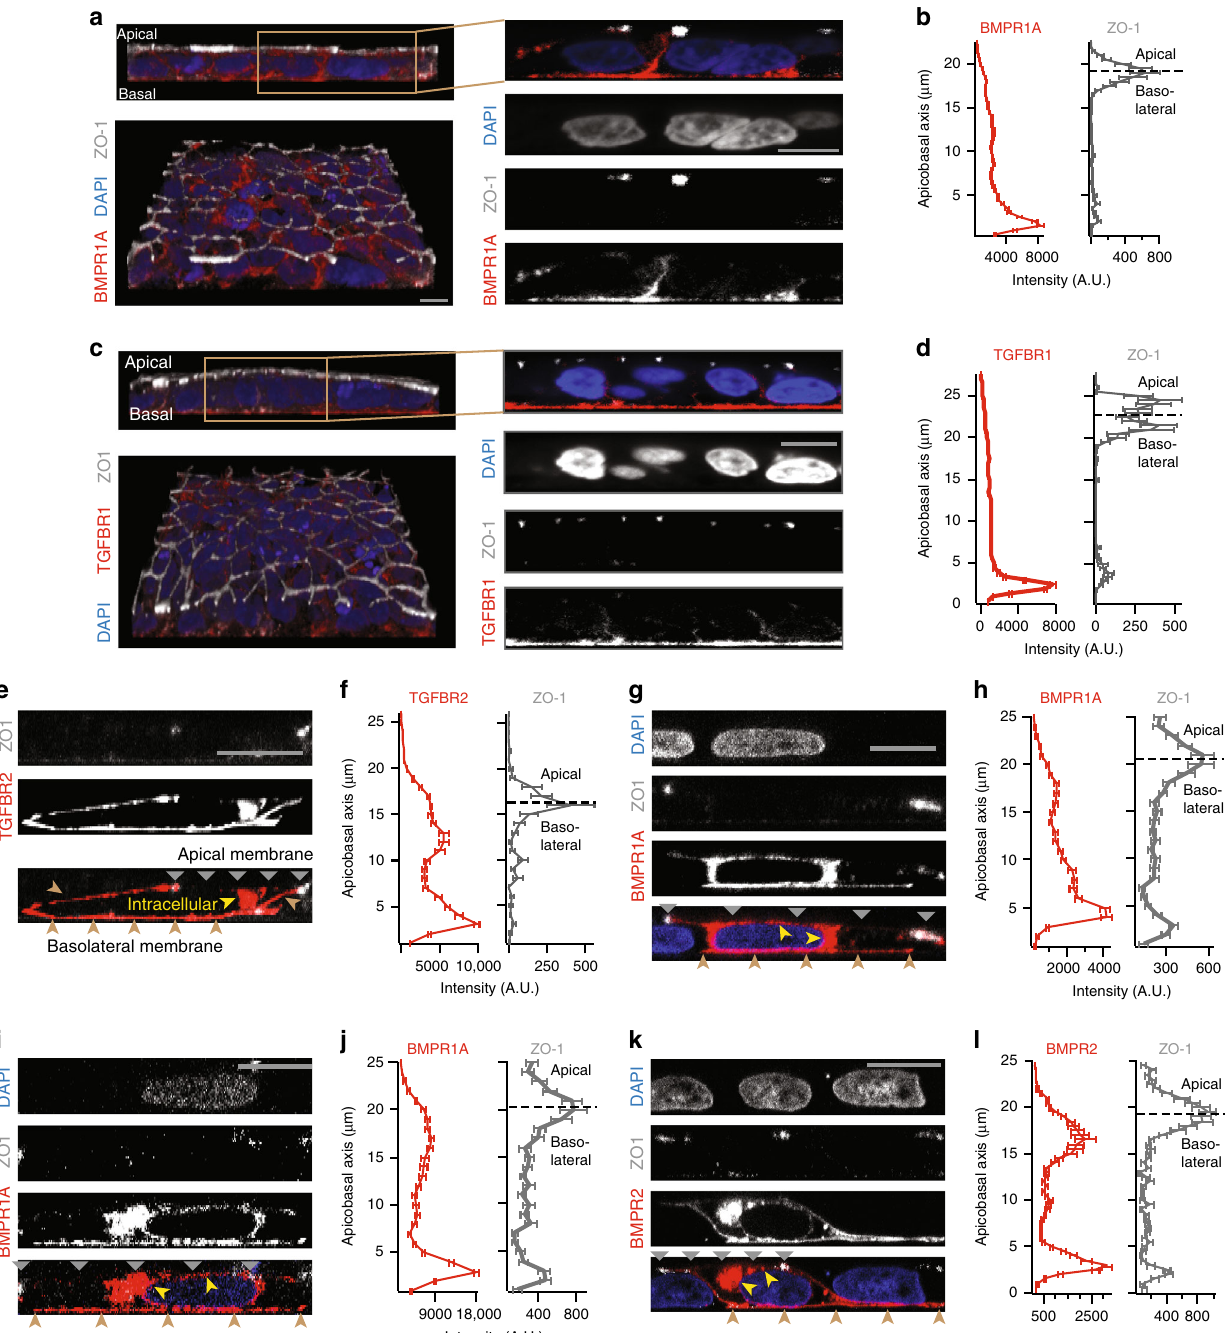
Fig. 2 BMP and TGF- β receptors localize at basolateral membrane of hESCs in vitro. a Left column: 3D confocal images of hESC colony stained for BMPR1A (red), tight junction marker ZO-1 (white), and DNA (blue), in lateral (top) and tilted view (bottom). Right column: Zoomed-in lateral images. Scale bar 10 µ m. b Plots of BMPR1A (left) and ZO-1 (right) staining intensity along apicobasal axis show BMPR1A localized beneath tight junctions ( n = 38 cells from two experiments). c Left column: 3D confocal image of hESC colony stained for DNA (blue), TGFBR1 (red), and ZO-1 (white) in lateral (top) and tilted view (bottom). Right column: Zoomed-in lateral section. d Plots of TGFBR1 (left) and ZO-1 levels (right) against apicobasal axis show that TGFBR1 is localized below tight junctions ( n = 51 cells from two experiments). e Confocal image of a hESC expressing TGFBR2-Clover (red), stained for ZO-1 (white). f TGFBR2-Clover (left) and ZO-1 levels (right) against apicobasal axis ( n = 4 cells from two experiments). g , h Same as e , f but for BMPR1A-Clover ( n = 2 cells from two experiments). i , j Same as e , f but for BMPR1A-HA ( n = 3 cells from two experiments). k , l Same as e , f but for BMPR2-Clover ( n = 3 cells from two experiments). Yellow arrows in e , g , i, k denote intracellular receptors in secretory pathway. Gray and brown arrows indicate apical and basolateral membranes, respectively. Scale bar 10 µ m. Error bars denote